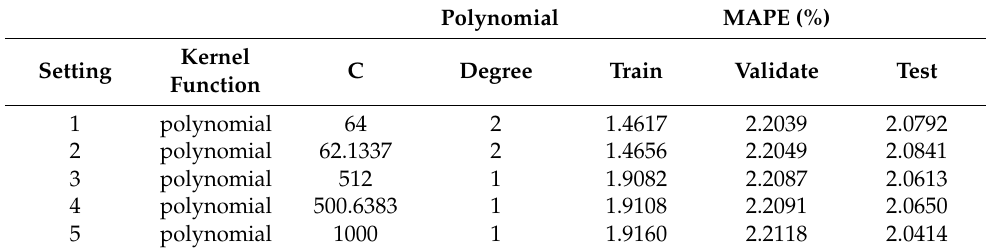
Table 9. Best five settings of SVM from grid search.